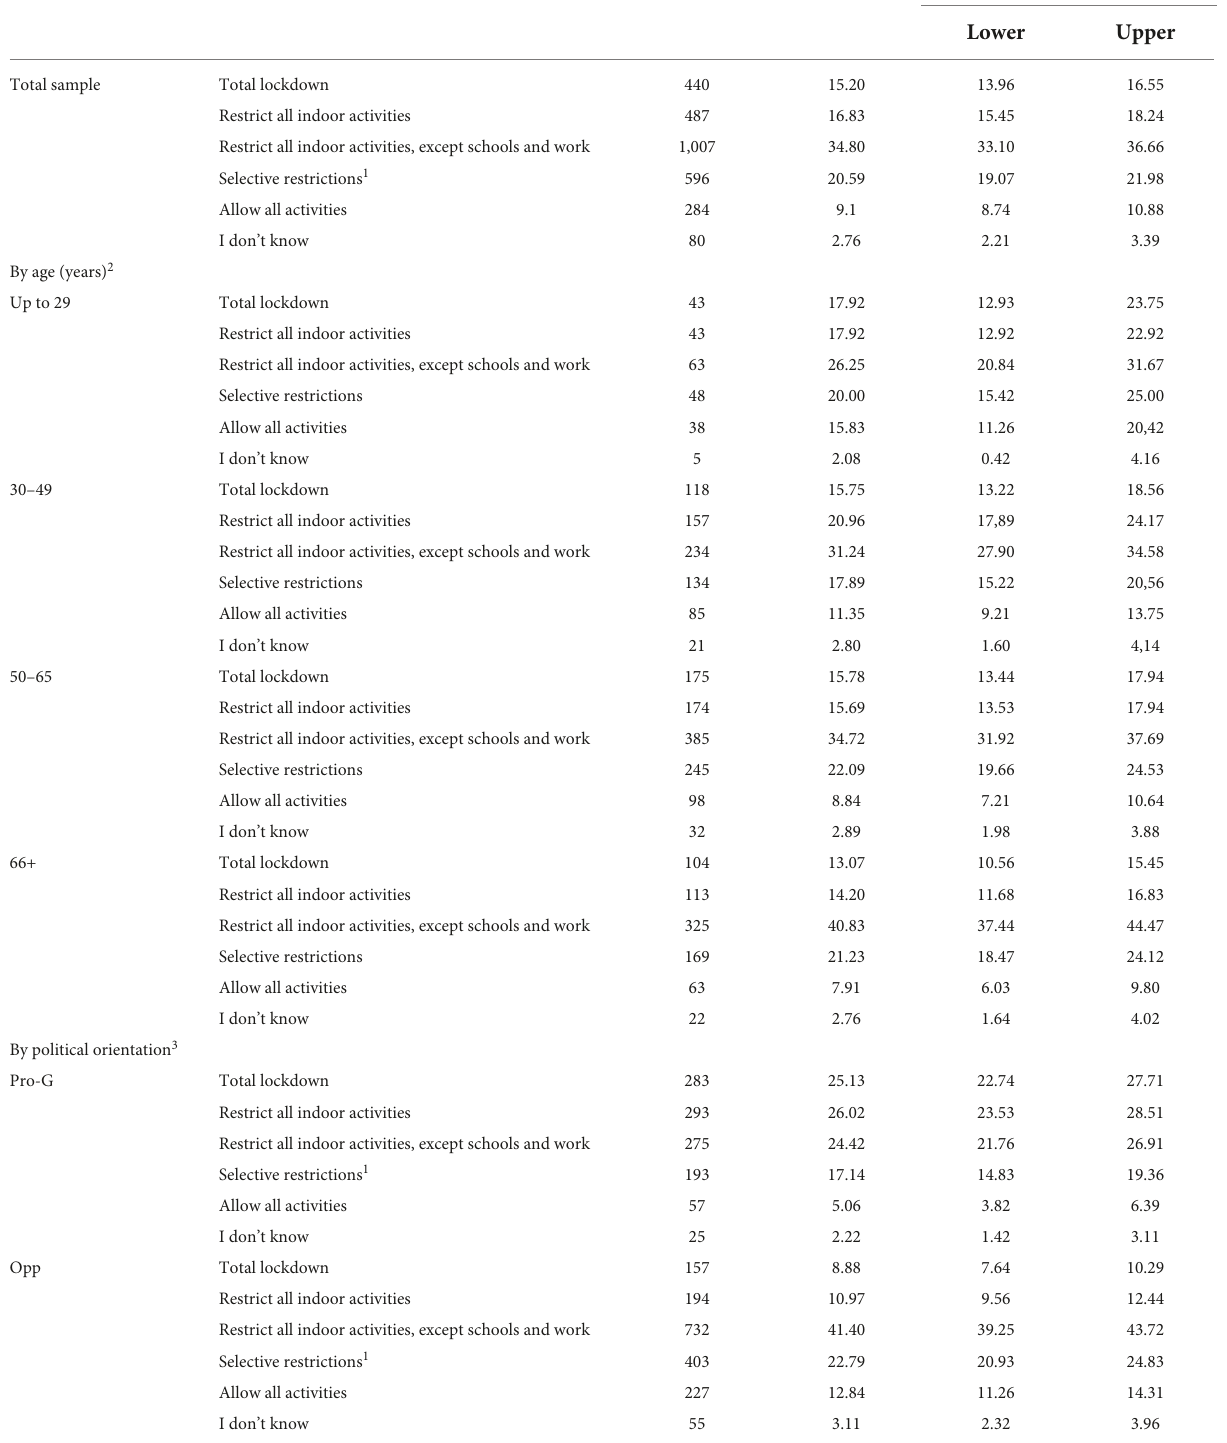
TABLE 3 Participants support for government restrictive